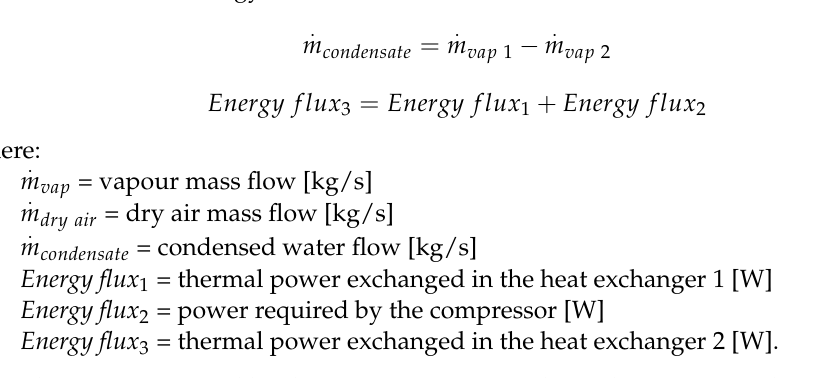
Figure 2. Air to water generators (AWG) reverse thermodynamic cycle: mass and energy fluxes. On the basis of the above scheme, it is possible to write two balance equations, which represent mass and energy conservation: